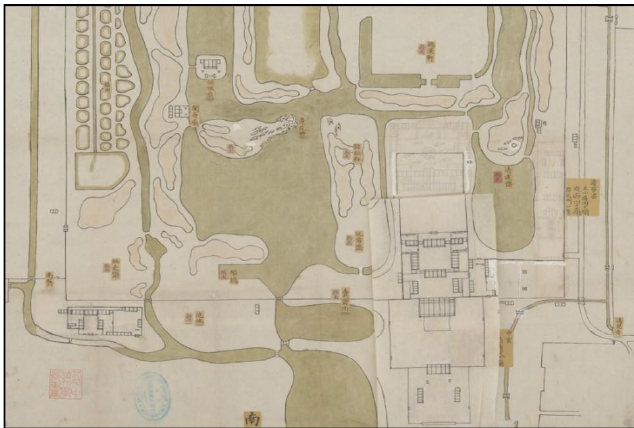
Figure 2 Artwork “ Wanshou Shengdian ” , where Jiujing Sanshi Hall is shown